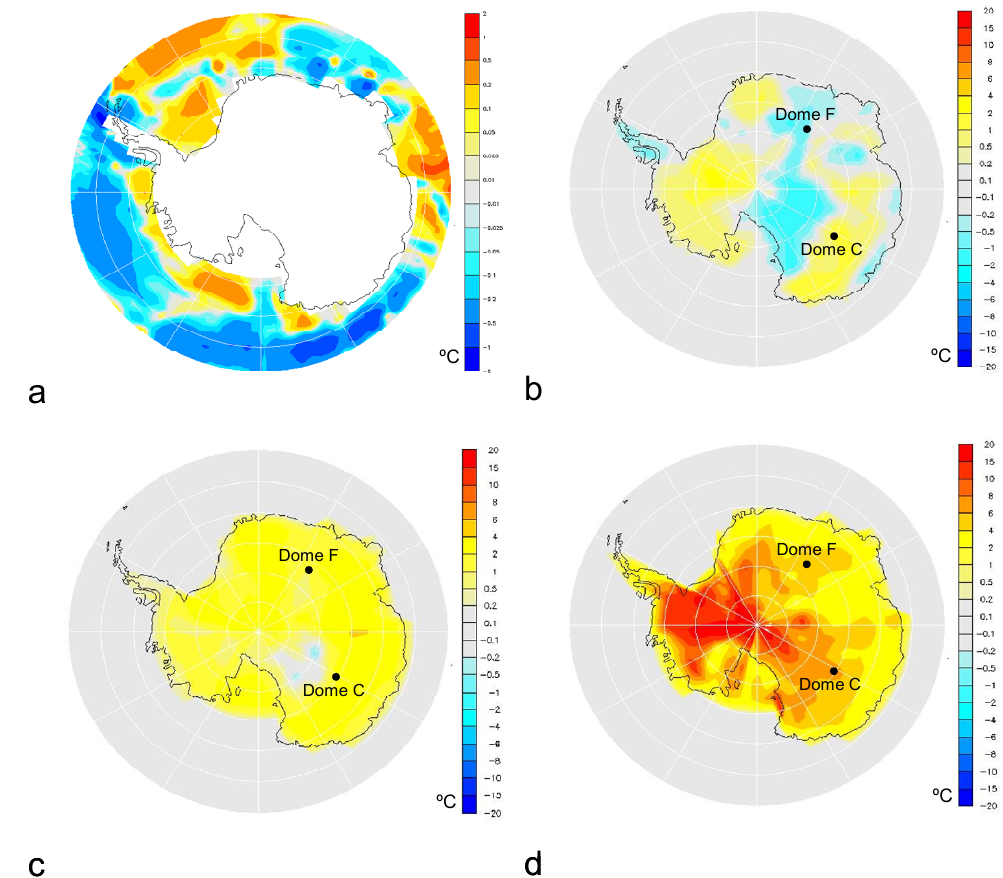
Fig. 5. HadCM3 SST and SAT anomalies at 130000BP. (a) Southern summer freshwater-induced SST anomaly due to 1Sv North Atlantic hosing applied uniformly between 50–70 ◦ N (H FW -H NFW ) . (b, c, d) Precipitation-weighted SAT anomalies relative to preindustrial (b) with no hosing (H NFW -H PI ) , (c) including hosing (H FW -H PI ) , (d) including hosing and with WAIS removed to land at 200m (H WAIS -H PI )